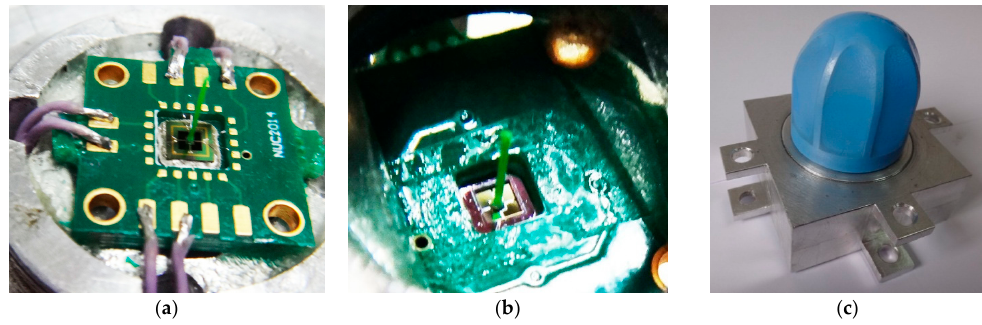
Figure 14. Prototype of differential MEMS vector hydrophone. ( a ) the upper cilium; ( b ) the lower cilium; ( c ) prototype.